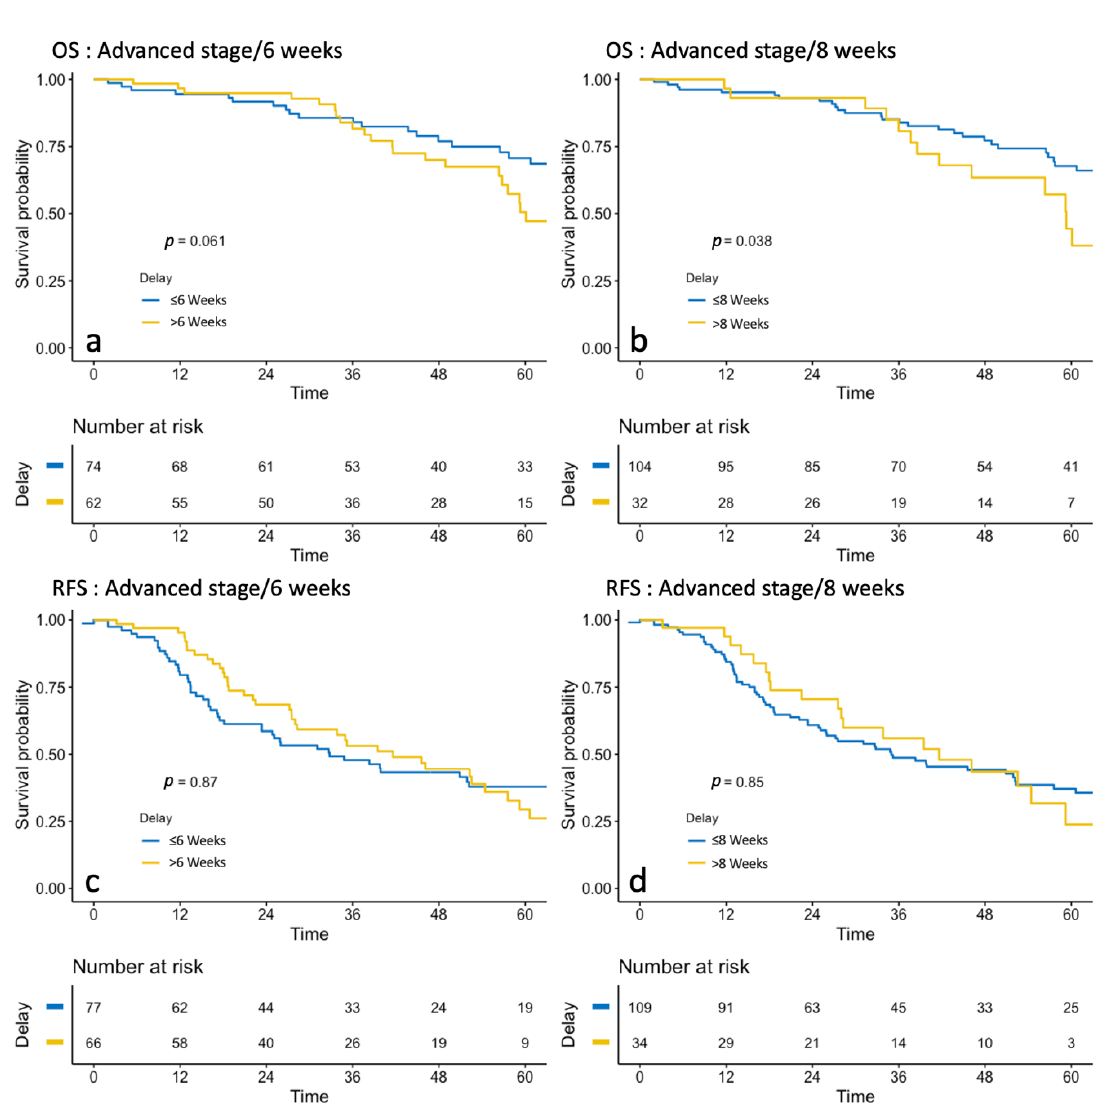
Figure 3. Survival analysis of Overall Survival (OS) (before and after 6 weeks: ( a ), before and after 6 weeks: ( b ) and Recurrence-free Survival (RFS) (before and after 6 weeks: ( c ), before and after 6 weeks: ( d ) in Advanced stages.